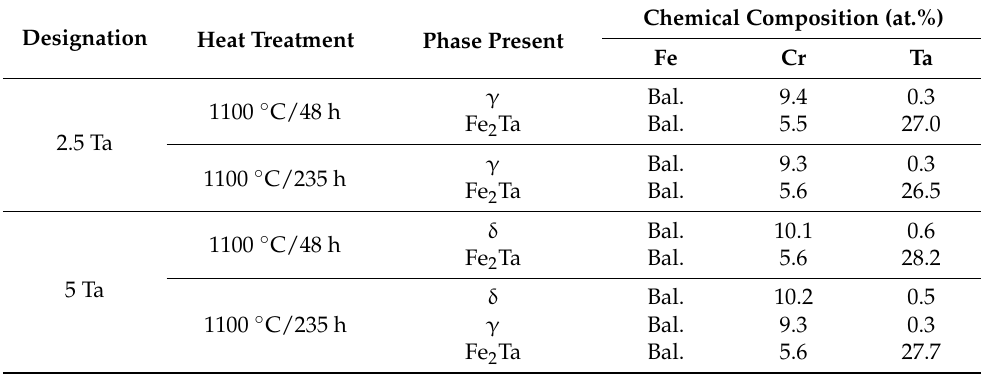
Table 4. The analyzed chemical compositions of the phases present in the Ta-doped ternary alloys after heat treatments, followed by water